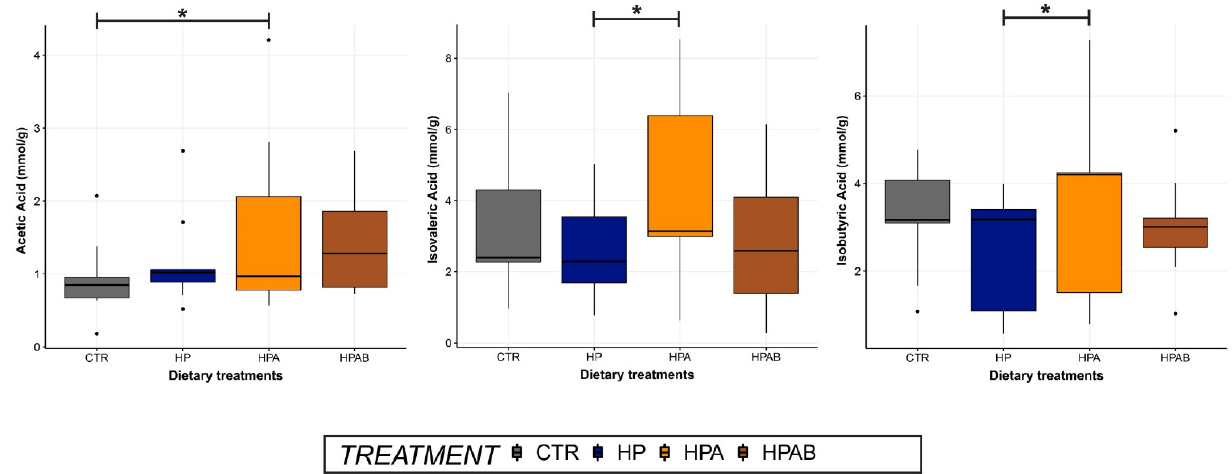
Figure 3. Faecal concentrations of acetic, isovaleric and isobutyric acids before the initiation of the study (CTR) and at the end of each dietary treatment. Data are represented as box and whisker plots showing median, quartiles, range, and outliers. Asterisks indicate statistical significance ( p < 0.05). CTR: Control diet; HP: Hydrolysed protein diet; 2) HPA: Ascophyllum nodosum -supplemented HP diet; HPAB: B. subtilis C-3102 fortified HPA diet.